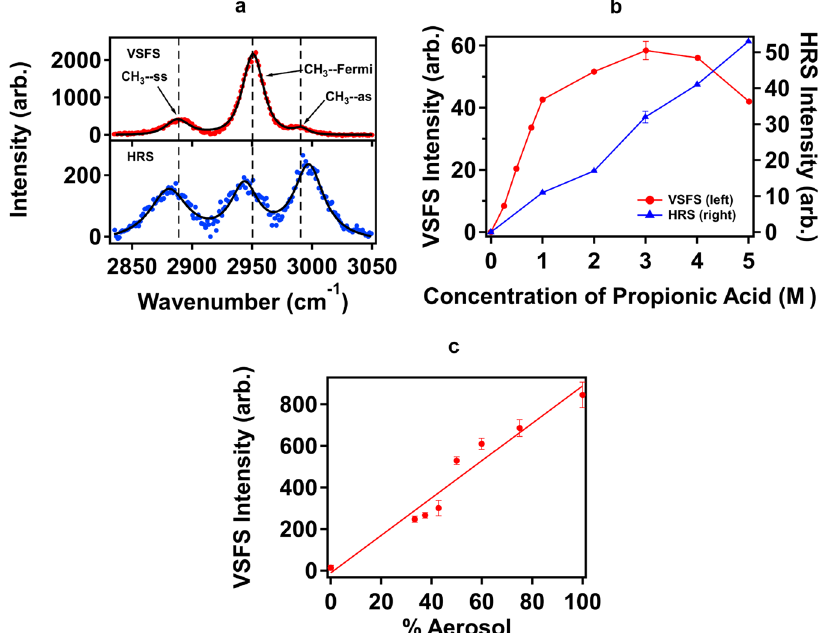
Fig. 2 Spectra and isotherms of vibrational sum frequency (VSFS) and hyper-Raman scattering (HRS) experiments. a HHH-polarized (H = horizontal polarization) con fi guration spectra for VSFS (upper) and HRS (lower) for aerosol particles from a 0.5 M NaCl seed solution with 4.0 M propionic acid. b VSFS (red solid circle, left axis) and HRS (blue solid triangle, right axis) intensities at 2991.8 cm − 1 (CH 3 -as) as a function of propionic acid concentrations added. Error bars represent 5% deviation. c Relationship of aerosol particle density to VSFS intensity. Error bars represent 1 standard deviation.